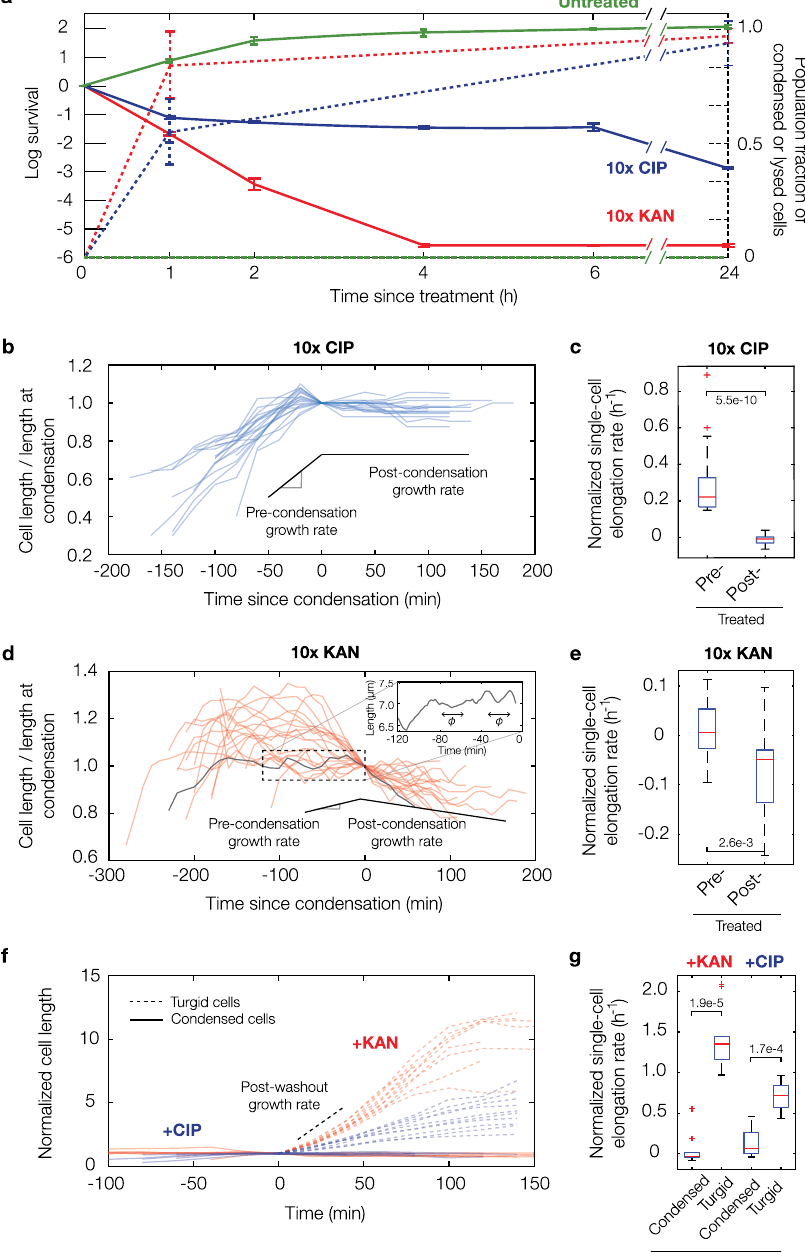
Fig. 3 Cytoplasmic condensation is an irreversible cell death phenotype. a Survival of log-phase bulk cultures of E. coli treated with kanamycin and cipro fl oxacin at 10× MIC and corresponding fractions of condensed and lysed cells after treatment for 24 h. Each timepoint represents two biological replicates and, for population fractions, two different fi elds of view with at least 100 cells each (untreated, 109 and 100 cells; kanamycin, 113 and 102 cells; cipro fl oxacin, 175 and 120 cells). For population fractions, a population of cells was treated with antibiotics for the indicated treatment times inside a micro fl uidic chamber, cells were washed with drug-free medium, and the number of condensed and lysed cells after 20 h were counted. Error bars indicate one standard deviation, and data are presented as mean ± SEM. b E. coli cell length ( L ) traces of 20 cells treated continuously with cipro fl oxacin at 10× MIC inside a micro fl uidic chamber. c Average normalized single-cell elongation rates ( dL/(Ldt) ) of cells corresponding to panel ( b ), with pre-condensation (pre-) and post-condensation (post-) values shown. Here and below, box plots indicating the median (center), 25th and 75th percentile (bounds of box), and extreme data points not considered outliers (bounds of whiskers) are shown, and red crosses indicate outliers including the minimum and maximum values. p -values for two-sample Kolmogorov-Smirnov tests are shown next to corresponding brackets. d – e Same as ( b , c ), but for treatment with kanamycin at 10× MIC, for which cells exhibited cell length oscillations approximately described by a typical period of ф = 20 min (inset). Box plot features refer to those of panel ( c ). f , g Same as ( b , c ), but for transient antibiotic treatment and subsequent washout, showing that recovering, turgid cells survive and continue to elongate. Here, time is de fi ned as time since condensation for condensed cells and time since start of measurement for recovering cells. Cell length represents cumulative cell length of a cell and, if the cell divides, all its progeny. The length is normalized to its value at condensation for condensed cells and to its starting length for recovering cells. All cells were treated for 30 min with kanamycin or cipro fl oxacin at 10× MIC inside a micro fl uidic chamber. Box plot features refer to those of panel c